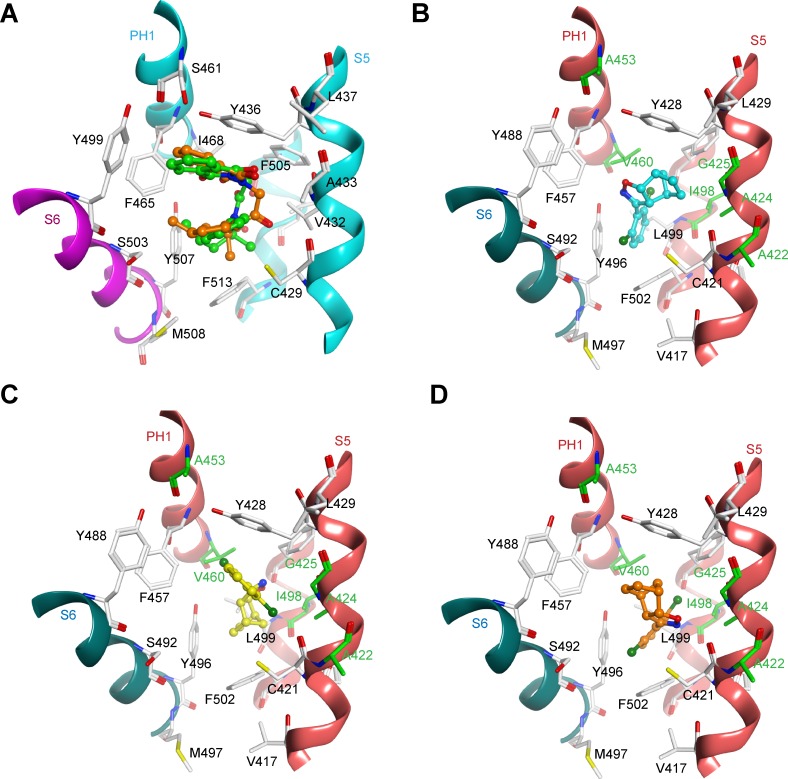
Additional molecular modeling of ML2-SA1 and ML-SA1 binding.(A) Comparison of the experimentally derived binding mode of ML-SA1 (green colored carbon atoms) and the docking pose (obtained with program GLIDE) at the hTRPML1 binding pocket (orange colored carbon atoms). The RMSD of the heavy atoms is 1.22 Å for the top-ranked solution. (B) Binding mode of the second ML2-SA1 enantiomer (cyan colored carbon atoms; absolute configuration: 3aR, 4R, 7S, 7aR) at hTRPML2 as predicted by ligand docking. The orientation is similar as observed for the enantiomer shown in Figure 3c and only the norbornane ring adopts a slightly different orientation. Only residues within 5 Å of ML2-SA1 in one of the four identical binding pockets are displayed. Binding was not different from the enantiomer (3aS, 4S, 7R, 7aS) shown in Figure 3D. (C–D) Alternative orientations (rank 2 and 3 of the GLIDE docking results) to that shown in Figure 3C of ML2-SA1 binding at hTRPML2.